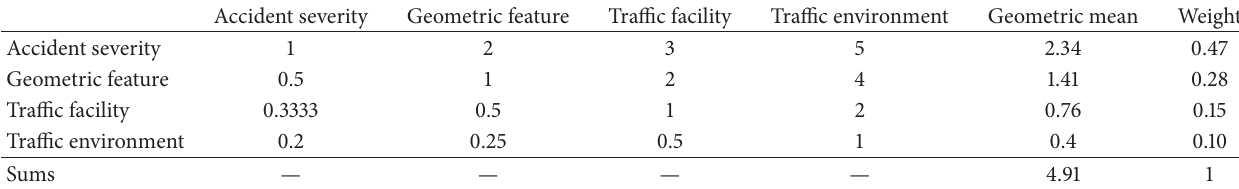
Table 1: Result of calculating the weight for evaluators.